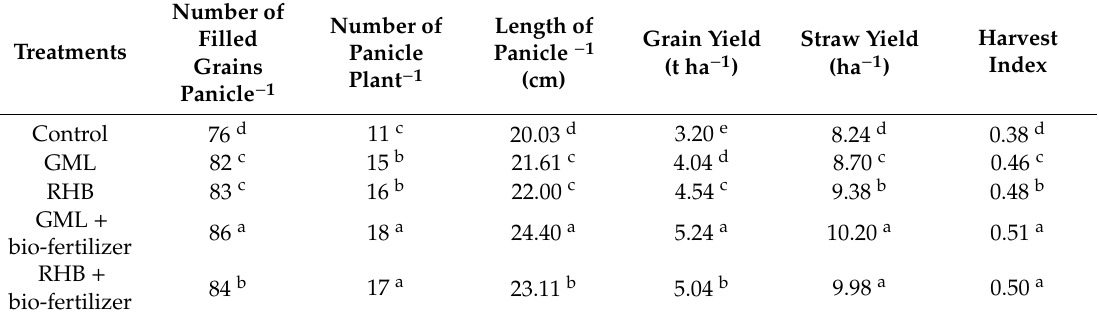
Table 7. E ff ects of applying amendments on rice yield and yield-contributing characters.